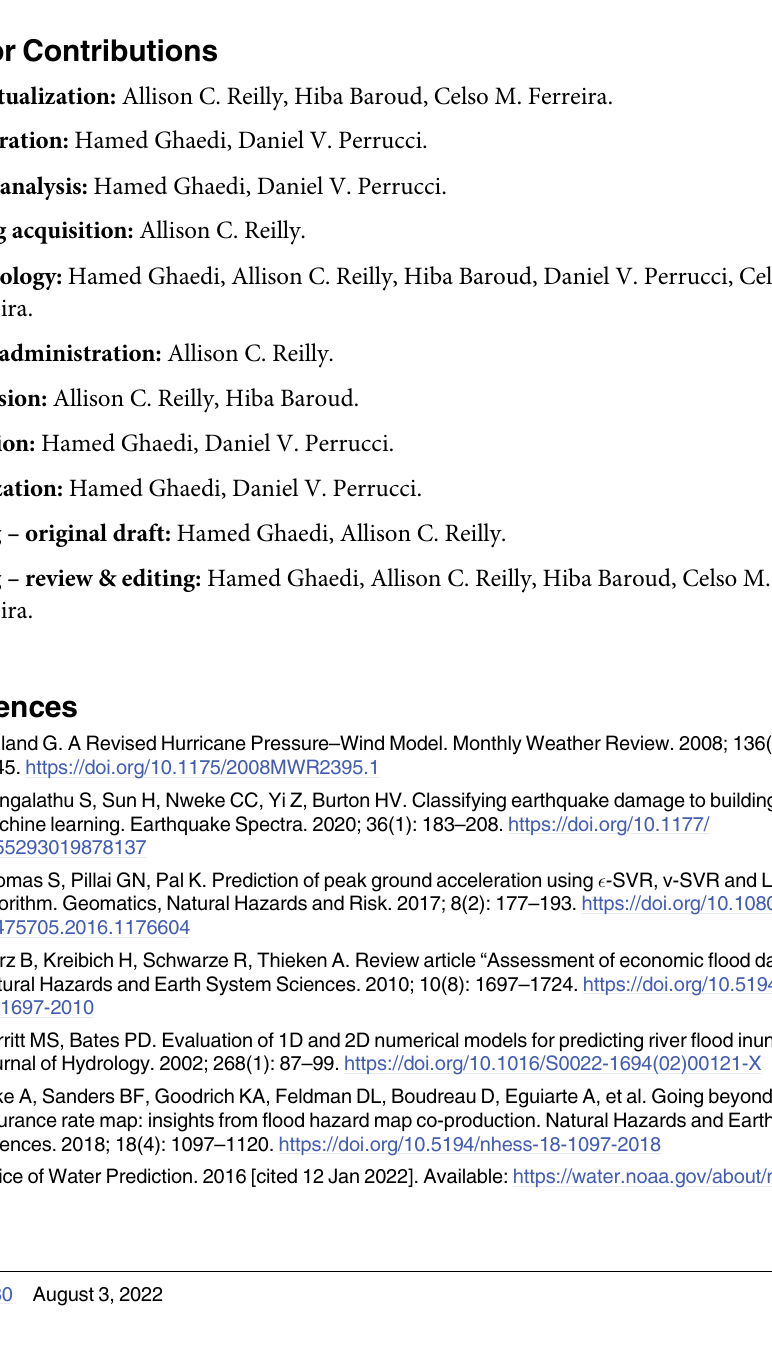
S2 Table. Total count of residential claims and policies in force (PIF) in 2016. (DOCX) S1 Methods. Classification and Regression Tree (CART), Random Forest (RF),